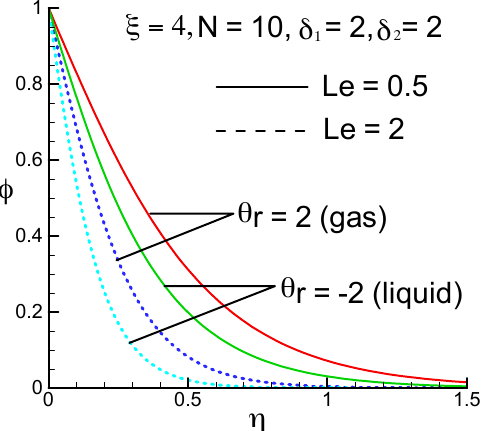
Figure 3. The dimensionless concentration profile for two values of Le and θ r .